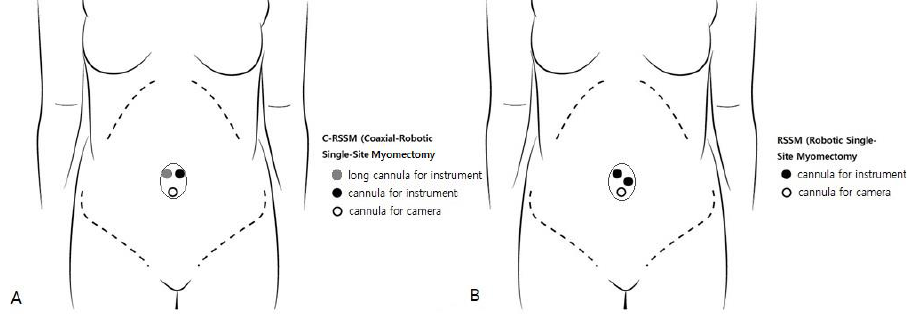
Figure 2. Placement of cannulas for C-RSSM ( A ) and RSSM ( B ) (view from above); C-RSSM, coaxial-robotic single-site myomectomy; RSSM, robotic single-site myomectomy.